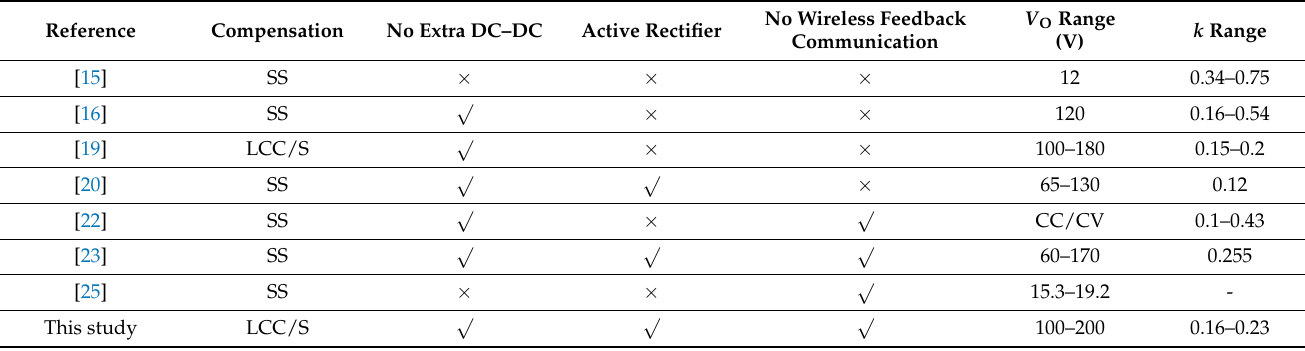
Table 3. Comparison with studies in the